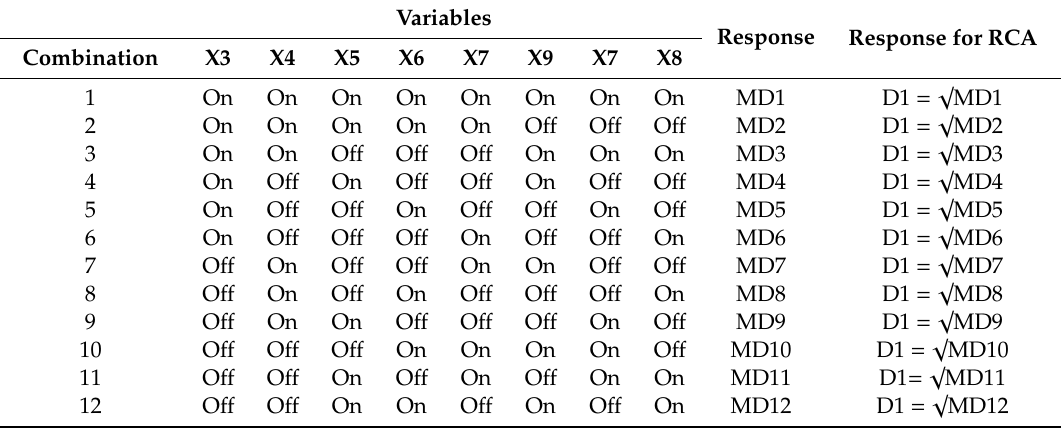
Table 12. Physical layout of corresponding to L 12 (2 8 ) orthogonal array with 11